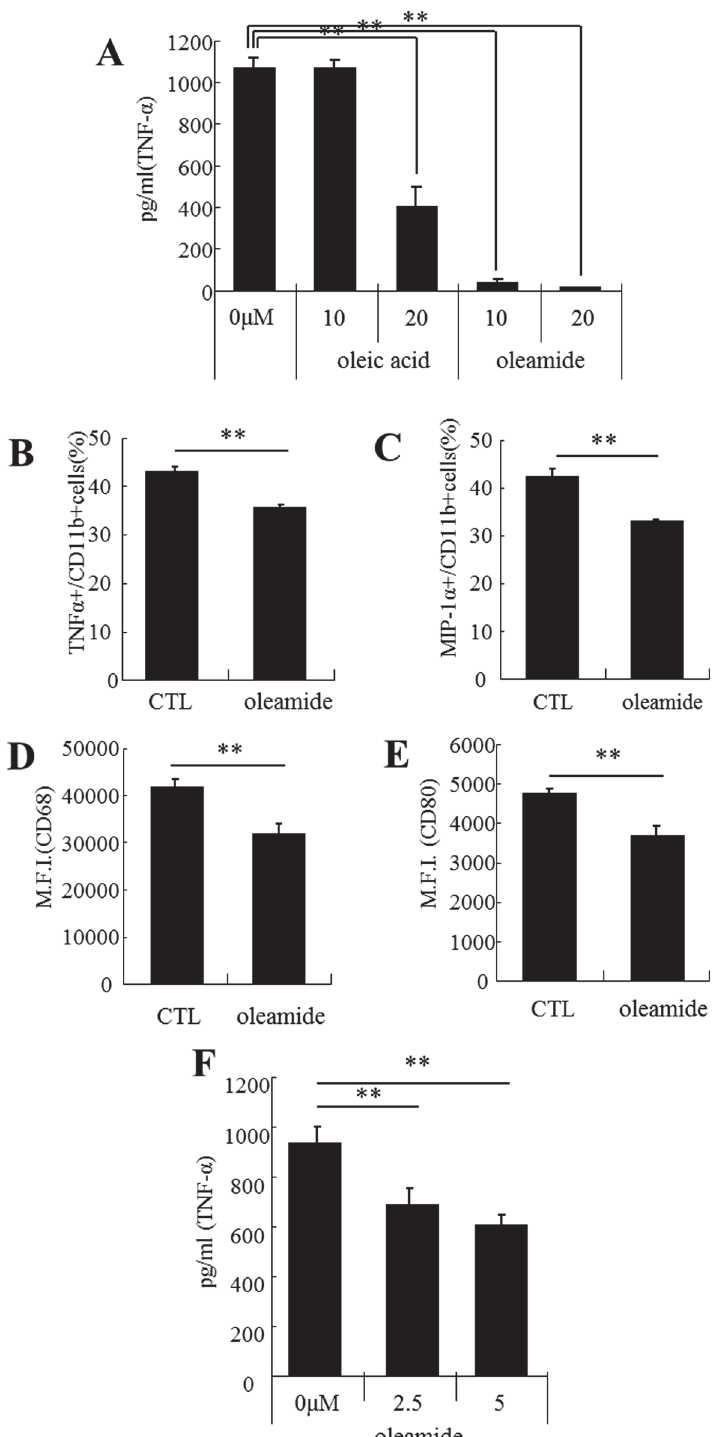
Fig 4. Effect of in vitro treatment with oleamide on microglial anti-inflammatory activity. A , Isolated microglia from C57BL/6J newborn were stimulated with 5 ng/ml of LPS and 0.5 ng/ml of IFN- γ after pretreatment with oleic acid or oleamide, and then TNF- α in the supernatant was measured by ELISA. B and C , Isolated microglia were pretreated with oleamide and incubated with PMA, ionomycin, and BD Golgiplug for 12 hours. The ratio (%) of or TNF- α -positive cells or MIP-1 α -positive cells to CD11b-positive cells (B